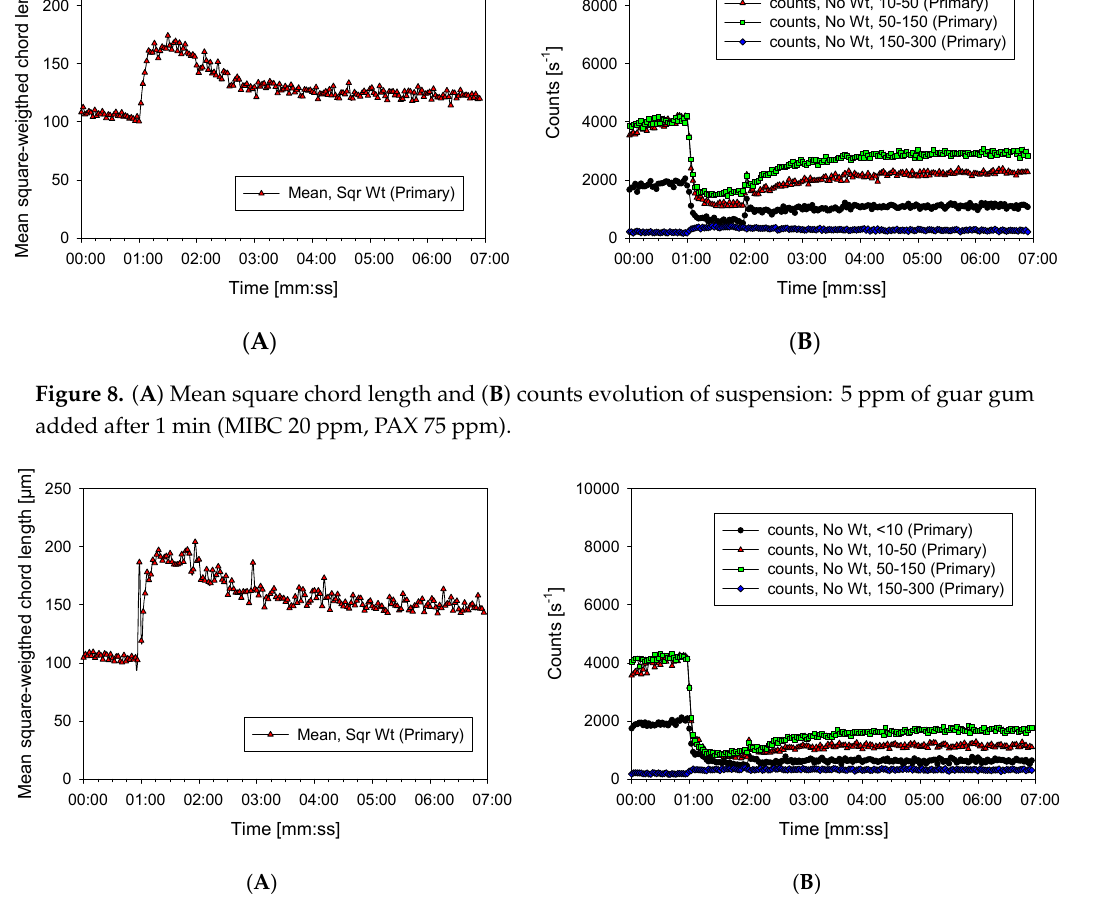
Figure 9. ( A ) Mean square chord length and ( B ) counts evolution of suspension: 100 ppm of guar gum added after 1 min (MIBC 20 ppm, PAX 75 ppm).